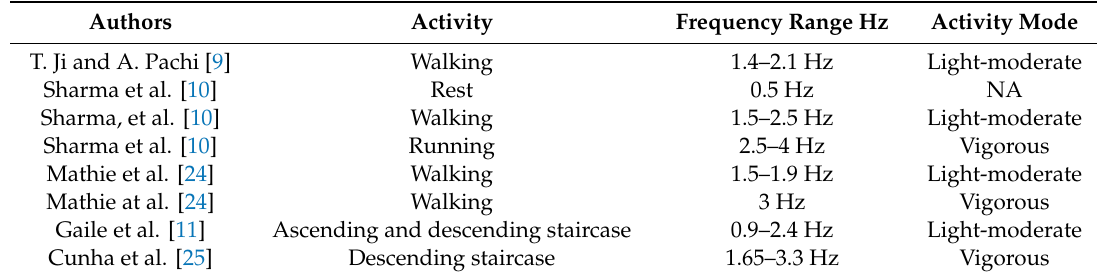
Table 1. The frequency domain ranges for di ff erent